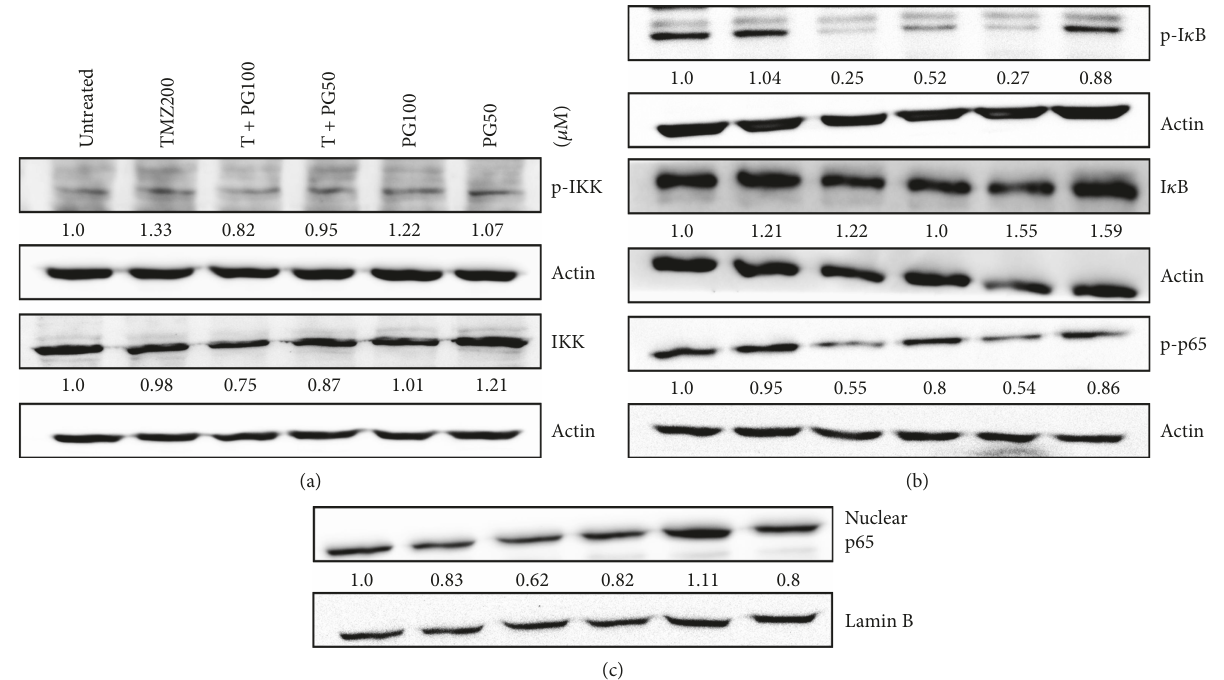
Figure 5: Expressions of (a) p-IKK and IKK; (b) p-I κ B, I κ B, and p-p65; (c) nuclear p65 with TMZ, PG, or TMZ/PG treatment. U-87 MG cells (2 × 10 6 ) were plated in 100mm cultured dishes for 24 h and then treated with TMZ (200 μ M), PG (50 or 100 μ M), or their combination for 48h. After treatment, total proteins or nuclear proteins were extracted to assess various protein expressions. Fifty micrograms of protein were loaded onto a 12% SDS-polyacrylamide gel and evaluated by Western blotting. These experiments were performed at least three times; a representative experiment is presented. Data indicate the densitometric values of various treated groups normalized to their corresponding untreated